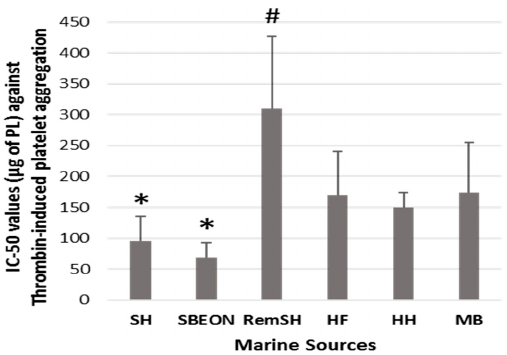
Figure 2. Antithrombotic activities of PL extracts from salmon, herring, and boarfish by-products against thrombin-induced aggregation of human platelets. Results are expressed as IC 50 (half-maximal inhibitory concentration) values that reflect the inhibitory strength of each PL extract against thrombin-induced platelet aggregation and is expressed as mean values of µ g of PLs in the aggregometer cuvette that causes 50% of inhibition of thrombin-induced aggregation of platelets in hPRP ± SD. It should be noted that the lower the IC 50 value, the stronger the inhibition against the platelet agonist tested. * and # indicate statistically significant di ff erences ( p < 0.05) for the most and least bioactive